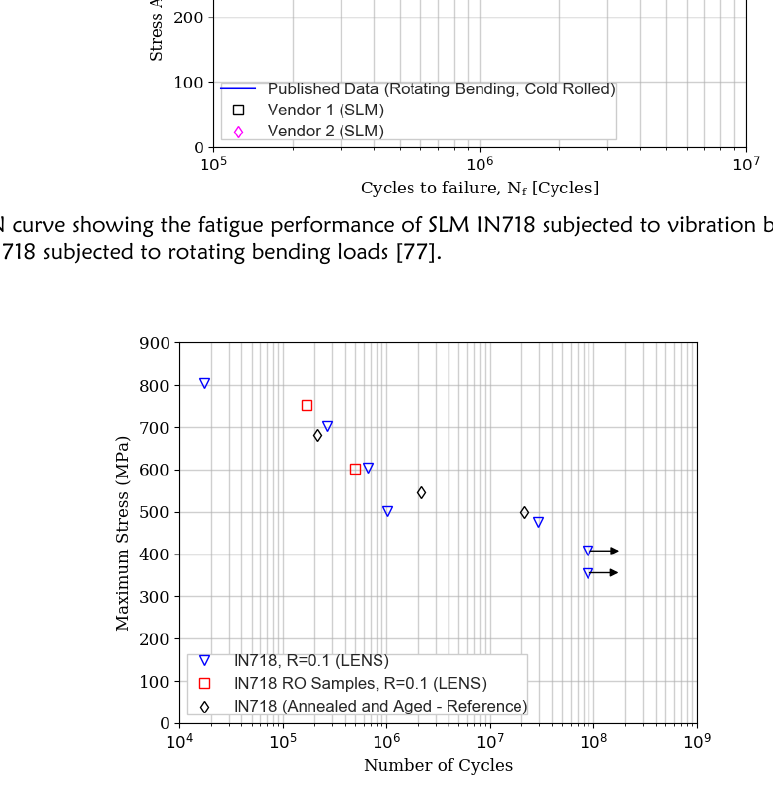
Figure 34: Fatigue data for IN718 fabricated by LENS process and tested by ultrasonic frequency fatigue testing. “RO” indicates run out